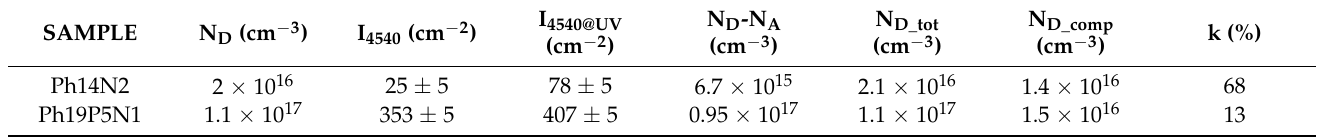
Table 1. Sample characteristics. Phosphorus donor concentrations (N D ) from SIMS, the integral intensity of the spectral line without (I 4540 ) and with (I 4540@UV ) laser irradiation, net (N D -N A ) and total (N D_tot ) phosphorus concentration from FTIR without and with UV irradiation,